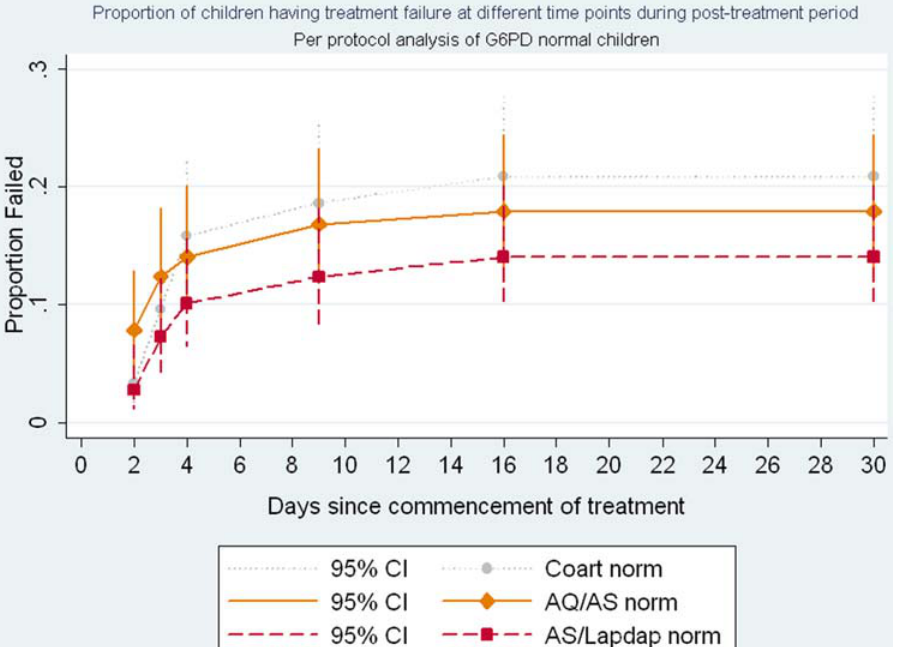
Figure 2. Proportion of children having treatment failures at different time points during the post treatment period Per protocol analysis of G6PD normal children.